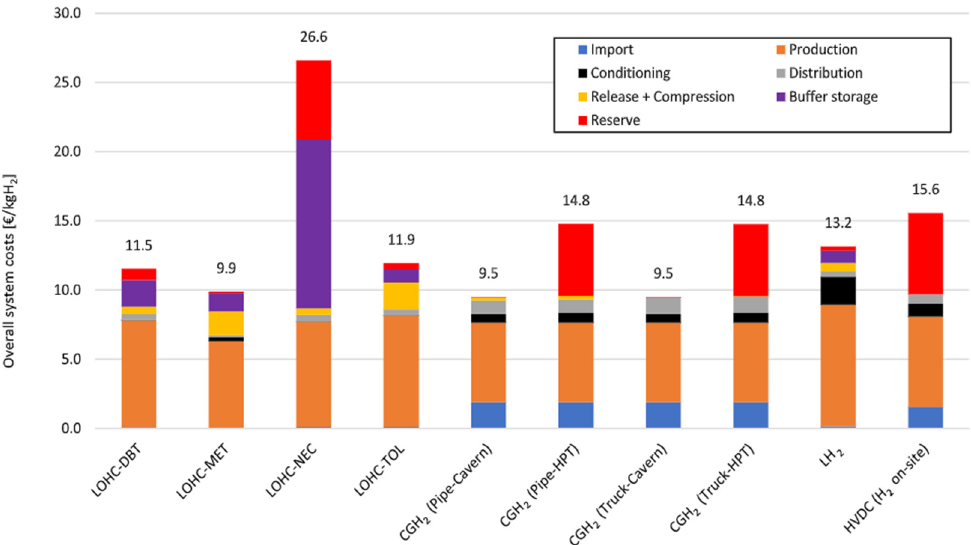
Figure 8. Overall system costs (OSC) of the assessed hydrogen supply chains (DBT: dibenzyltoluene, HPT: high-pressure tank, HVDC: High Voltage Direct Transmission, LH 2 : Liquefied Hydrogen, LOHC: Liquid Organic Hydrogen Carrier, MET: methanol, NEC: N-ethylcarbazole, Pipe: Pipeline, TOL: toluene). Reprinted/adapted with permission from Ref [75], copyright 2021 Elsevier .